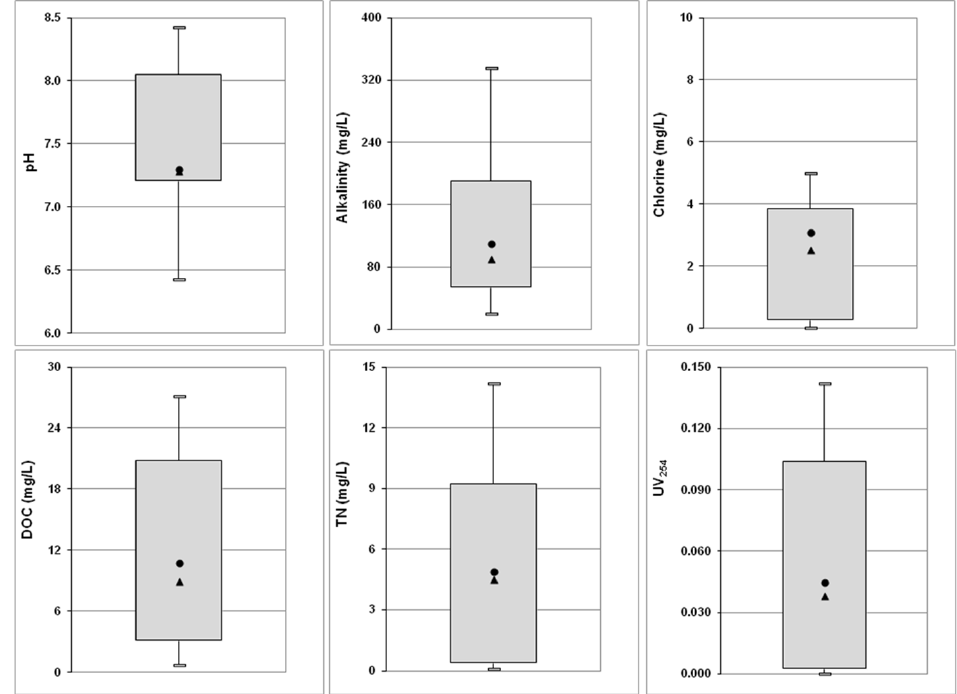
Figure 1. Water quality parameters in swimming pools (boxplots represent 10th and 90th percentiles, min and max values; circle and triangle represent mean and median values, respectively).